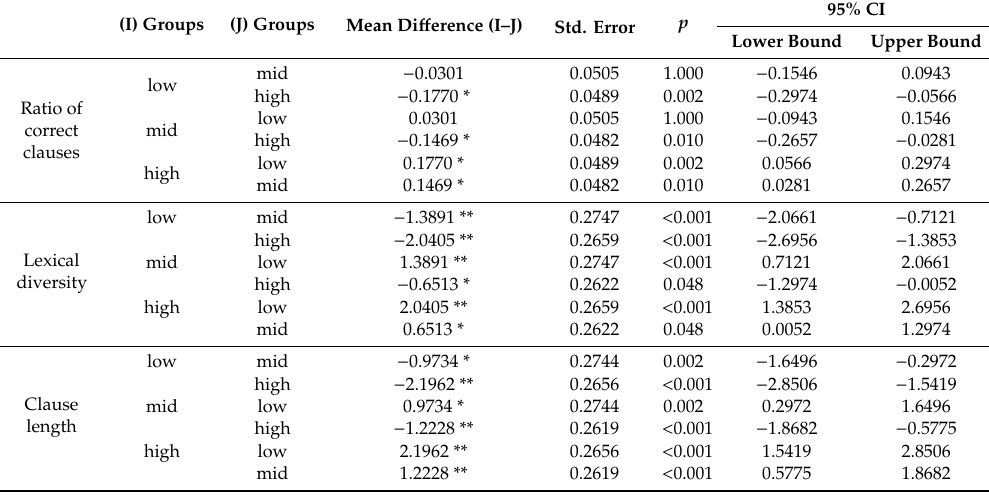
Table A4. Multiple comparisons with Bonferroni